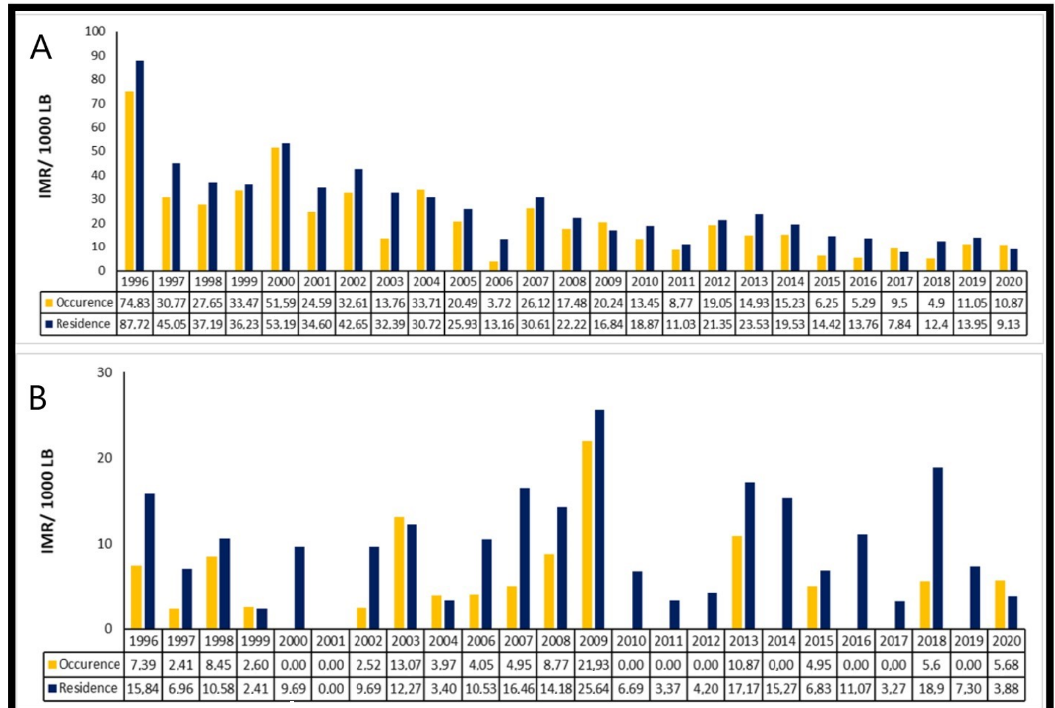
Figure 2. Comparison of infant mortality rate by occurrence and in the following selected cities in the South region: ( A ) Foz do Iguaçu and ( B ) Santo Antônio do Sudoeste. Brazil, 1996–2020.